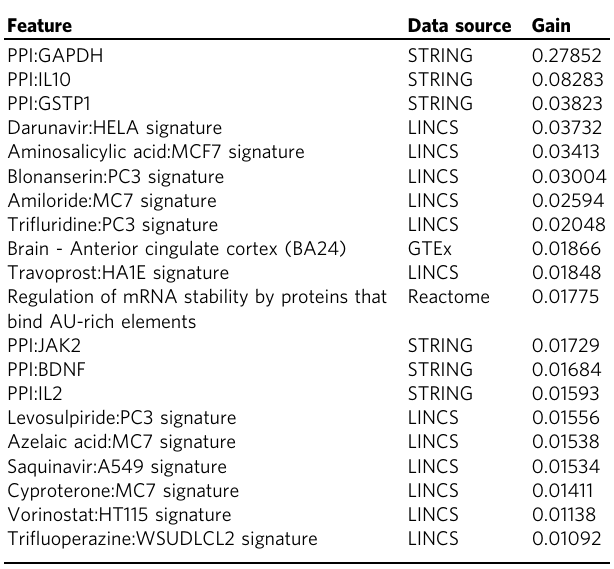
Table 1 Top 20 features used in the boosted trees of the AD- focused MPXgb